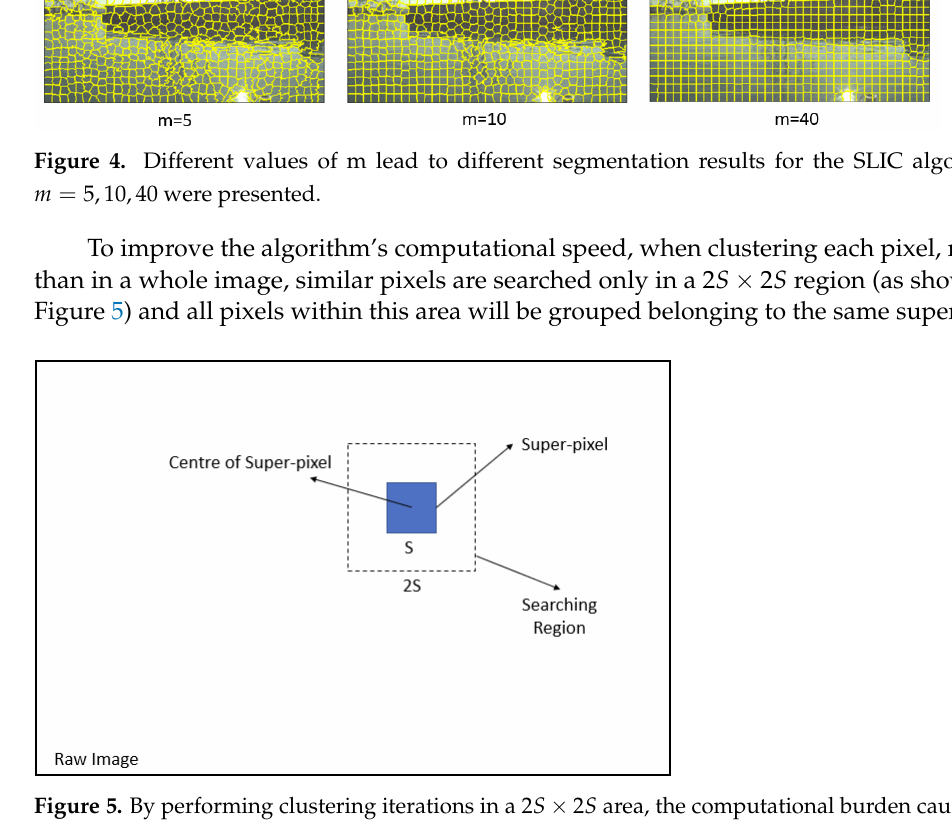
Figure 5. By performing clustering iterations in a 2 S × 2 S area, the computational burden caused by the increased number of superpixels can be greatly